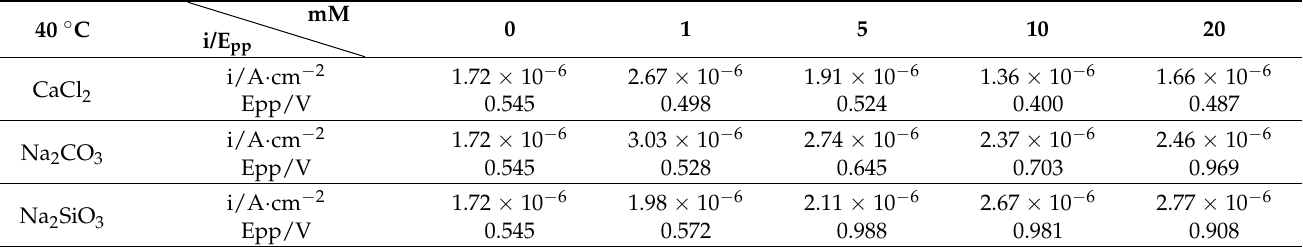
Table 4. Electrochemical parameters obtained from the fitted curves.